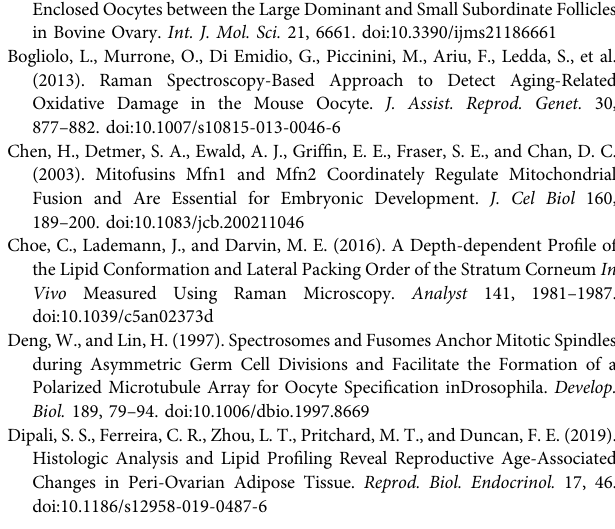
Supplementary Figure S2 | Quanti fi cation of lipid and protein turnover rates in Drosophilaovary.Atallstages,bothlipidandproteinturnoverratesweresigni fi